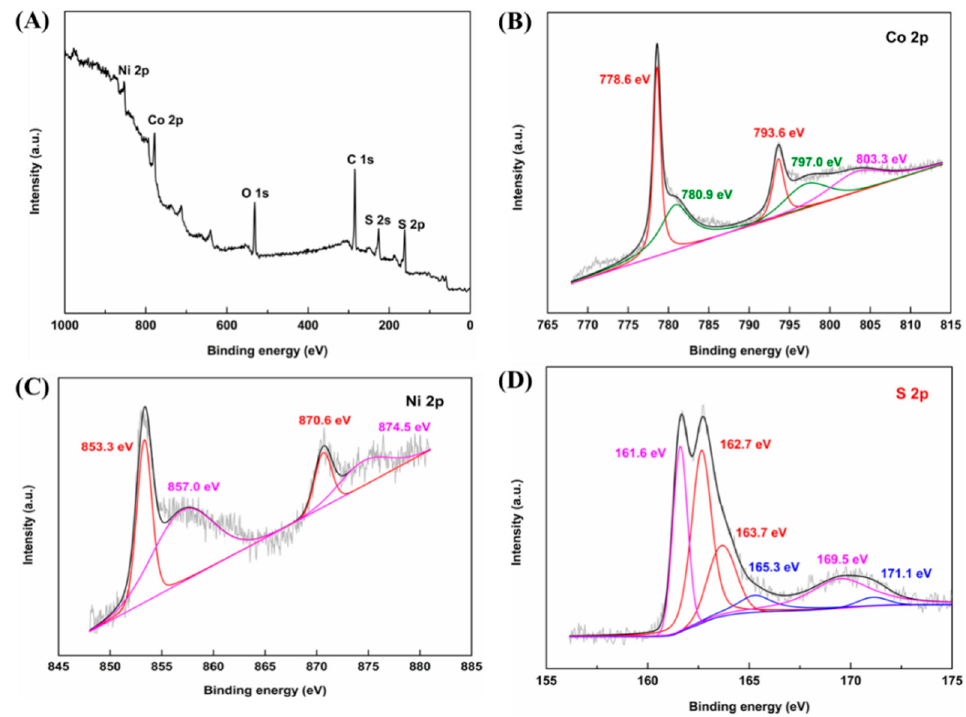
Figure 1. XPS spectra of Co 0.6 Ni 0.4 S 2 /rGO samples: ( A ) the wide-scan XPS spectrum, ( B ) Co 2p, ( C ) Ni 2p, ( D ) S 2p.